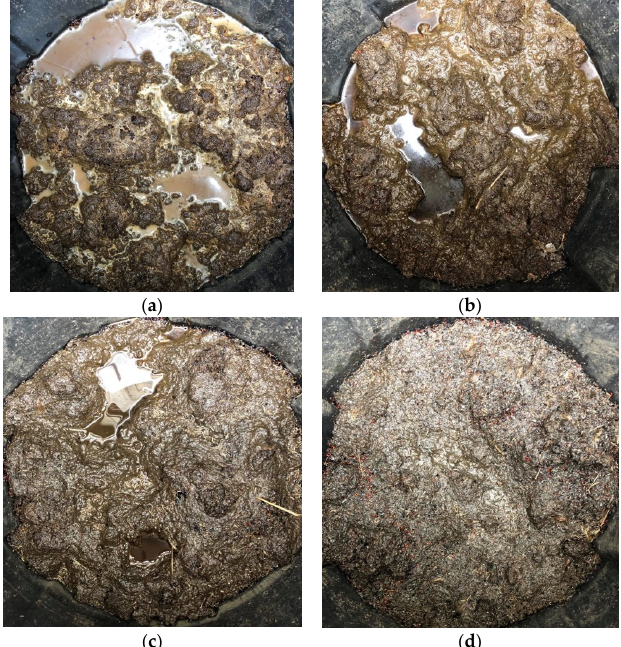
Figure 8. Water accumulation in PL blends for treatments containing 0% BC ( a ), 5% BC ( b ), 10% BC ( c ), and 20% BC ( d ). Less standing water was observed in treatments containing more BC, with 20% BC showing no observable standing water.